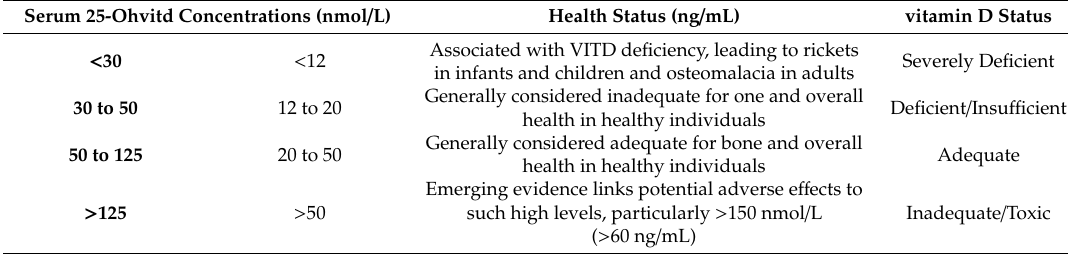
Table 1. Summarizes the thresholds for blood vitamin D (VITD) concentration stablish by the Institute of Medicine (IOM) and accepted by most organizations and researchers of vitamin D as well as its impact on people’s